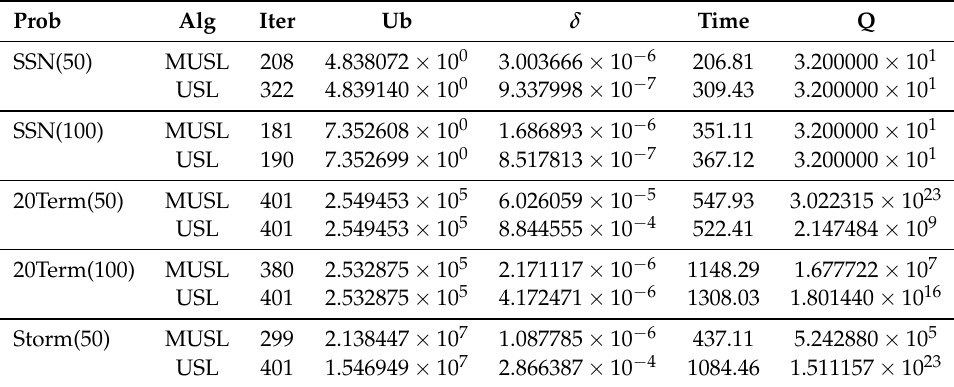
Table 3. MUSL and USL methods on SP instances.